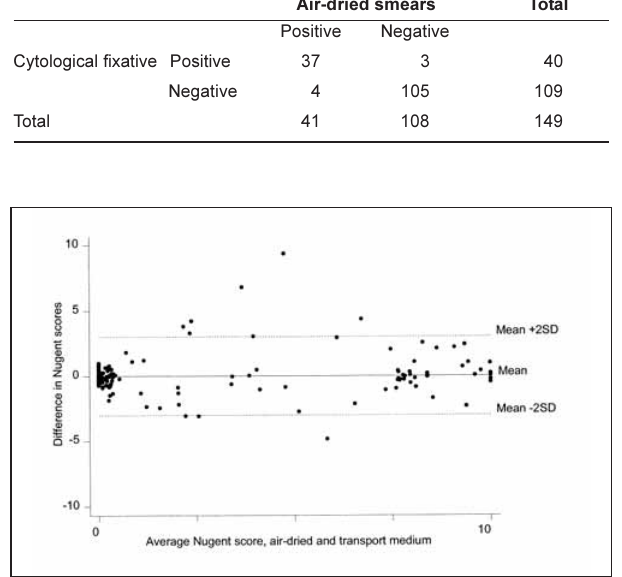
TABLE 3 Comparison of diagnoses of bacterial vaginosis from cytologically fixed smears and standard air-dried smears